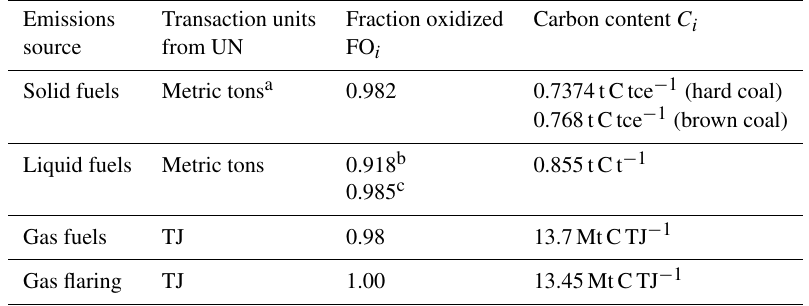
Table 1. Units in primary data source and calculation assumptions for fossil fuel combustion CO 2 emissions estimates. TJ: terajoules (10 12 J); tC: metric tons of carbon; tce: metric tons of coal equivalent; MtC: megatons (metric) of carbon (10 6 tC).